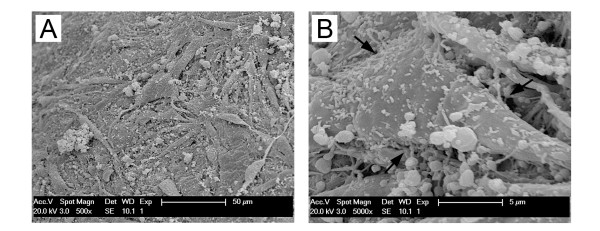
Scanning electron microscopy of MSC-laden PRP scaffolds. MSCs adhere to the PRP fibrin fibers (adhesion sites indicated by arrows in B). A) low magnification; B) high magnification. MSC, mesenchymal stem cell; PRP, platelet-rich plasma.